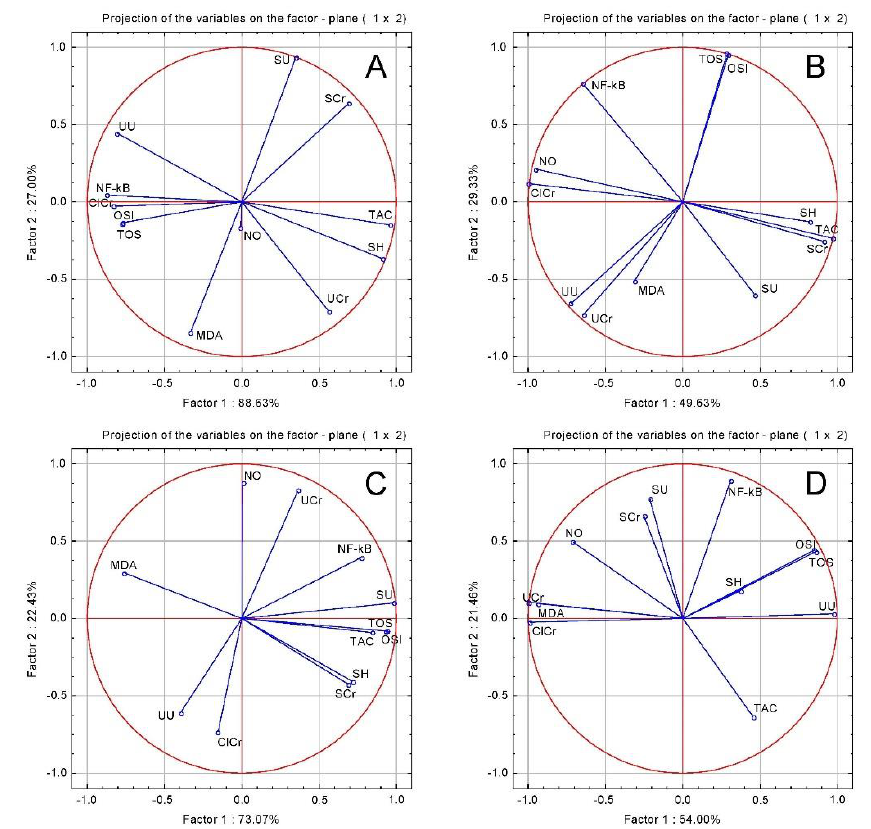
Figure 3. Oxidative stress and renal function tests PCA results: ( A ) GENTA group; ( B ) CHT; ( C ) CHT 1:1; ( D ) CHT 1:3. 1:1; ( D ) CHT